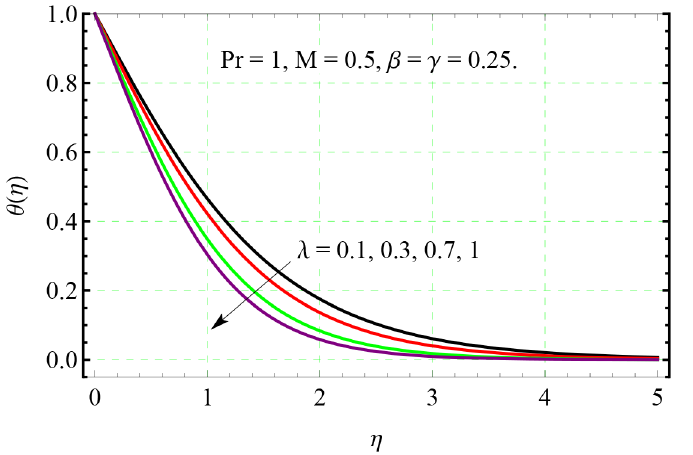
Fig 12. Effect of λ on θ ( η